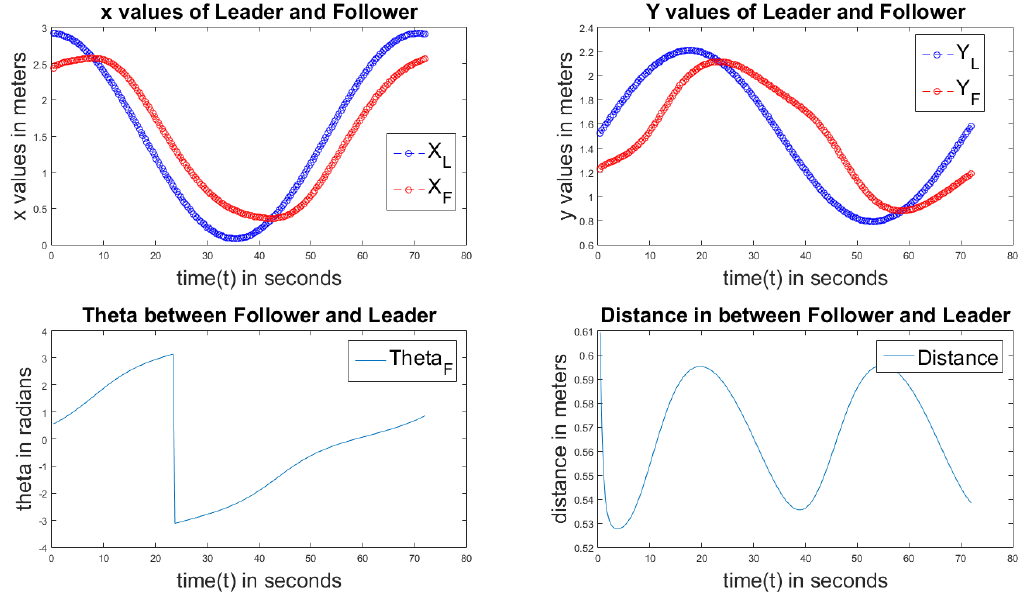
Figure 8. P controller of an ellipse.